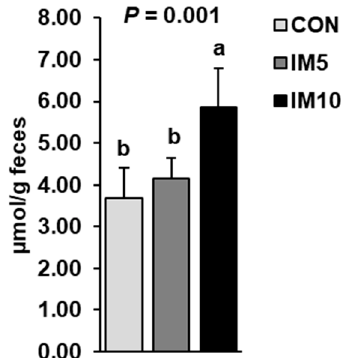
Figure 5. Concentrations of bile acids in the feces of pigs fed isonitrogenous diets without (CON) or with 5% (IM5) or 10% Tenebrio molitor larvae meal (IM10) for four weeks. Bars are means ± SD for n = 10 pigs per group. a,b Values with different superscripts differ significantly at p < 0.05.